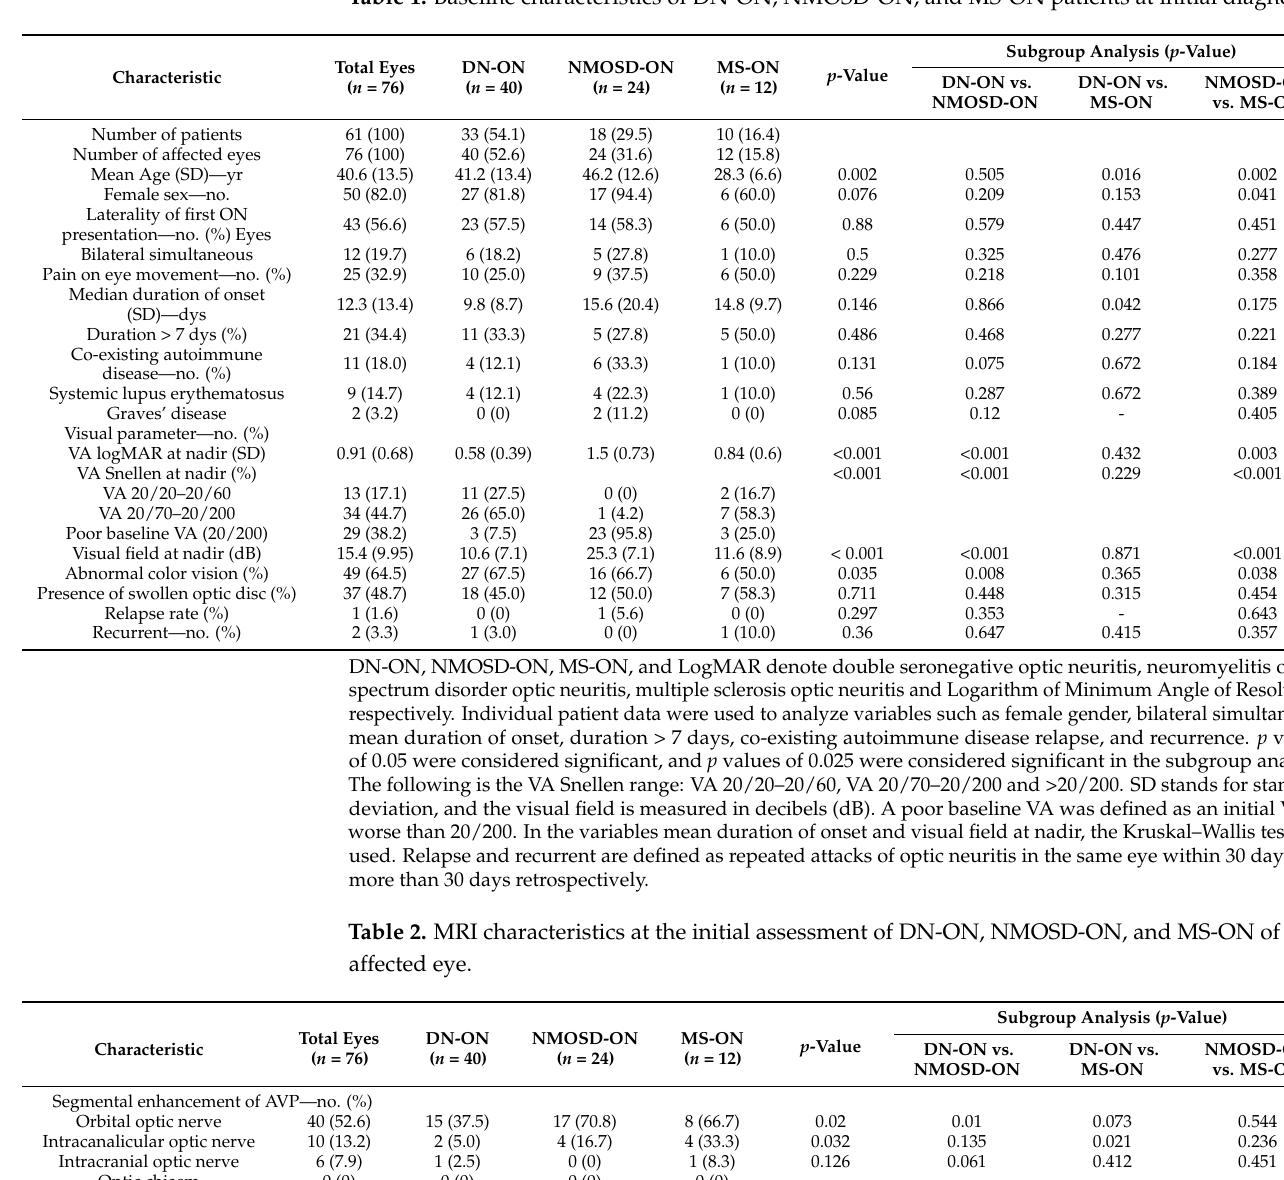
Table 1. Baseline characteristics of DN-ON, NMOSD-ON, and MS-ON patients at initial diagnosis.